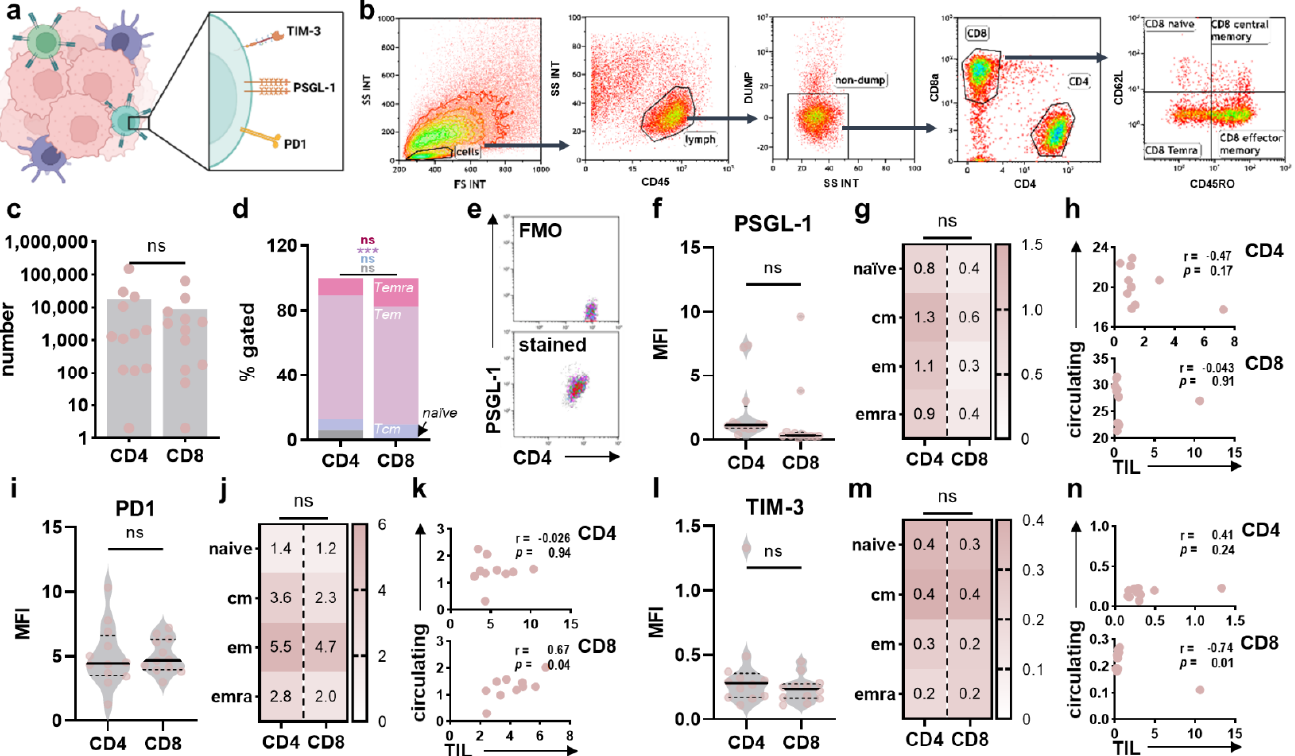
Figure 5. Immunophenotyping of tumor-infiltrating T cells in glioblastoma tissues. ( a ) schematic overview of marker expression profiling on intratumoral T cells in glioblastoma patients; ( b ) repre- sentative gating strategy to identify CD4 + and CD8 + T cells and their subpopulations in glioblastoma samples; ( c ) absolute numbers of CD4 + and CD8 + T cells; ( d ) frequency of CD4 + and CD8 + T naïve , T cm , T em , and T emra cells; ( e ) representative flow cytometry dot plot graphing of FMO and anti-PSGL-1 stained CD4 + T cells; ( f , g ) surface expression of PSGL-1 on intratumoral CD4 + and CD8 + T cells ( f ) and T naïve , T cm , T em and T emra subsets ( g ); ( h ) Pearson’s correlation between PSGL-1 expression on circulating and intratumoral CD4 + and CD8 + T cells; ( i , j ) surface expression of PD1 on intratumoral CD4 + and CD8 + T cells ( i ) and T naïve , T cm , T em , and T emra subsets ( j ); ( k ) Pearson’s correlation between PD1 expression on circulating and intratumoral CD4 + and CD8 + T cells; ( l , m ) surface expres- sion of TIM-3 on intratumoral CD4 + and CD8 + T cells ( l ) and T naïve , T cm , T em , and T emra subsets ( m ); ( n ) Pearson’s correlation between TIM-1 expression on circulating and intratumoral CD4 + and CD8 + T cells. Bar graphs show mean + individual values. Statistical analysis was performed using paired t -test (*** p < 0.001). ns = non-significant. FMO = fluorescence minus one. MFI = mean fluorescence intensity. cm = central memory. em = effector memory. emra = effector memory expressing CD45RA. TIL = tumor-infiltrating